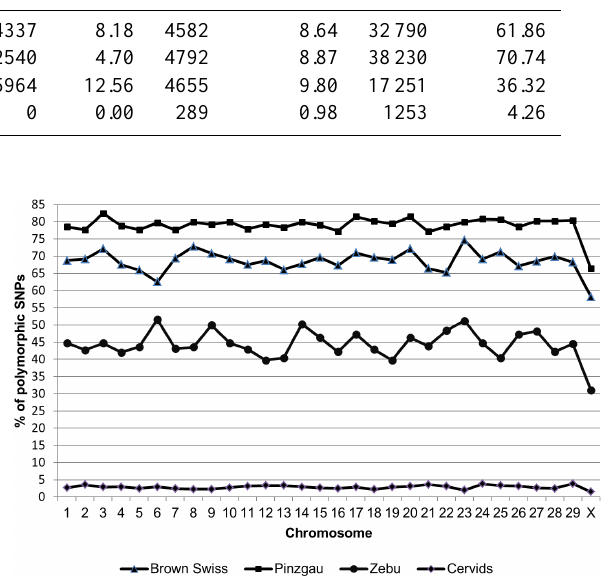
Figure 1. Proportion of polymorphic SNPs to the total number of SNPs for each chromosome on the BovineSNP50 BeadChip.